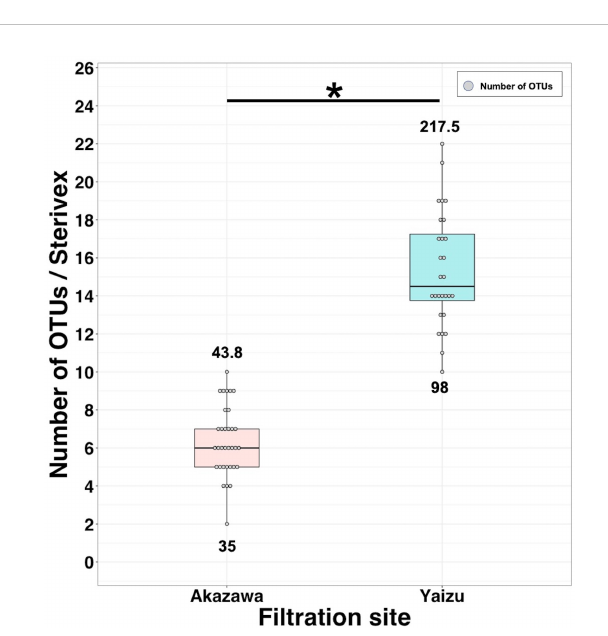
FIGURE 5 Nonmetric multidimensional scaling (NMDS) of fi sh OTU occurrence obtained from Akazawa and Yaizu. Analysis was performed using OTU read presence and Jaccard distance. Red and green circles indicate the fi ltered samples collected at Akazawa on September 14 and 15, 2020, respectively. Dark green and blue circles indicate the fi ltered samples collected at Yaizu on September 16 and 17, 2020, respectively. Convex hulls cluster samples according to collected sampling sites. NMDS stress value was